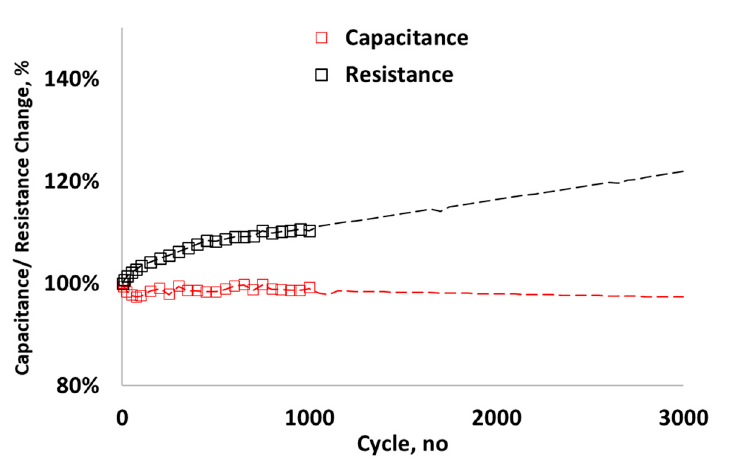
Figure 9. Cycle-life performance with SBP-BF 4 /ACN electrolyte: capacitance retention and series resistance change during cycling.